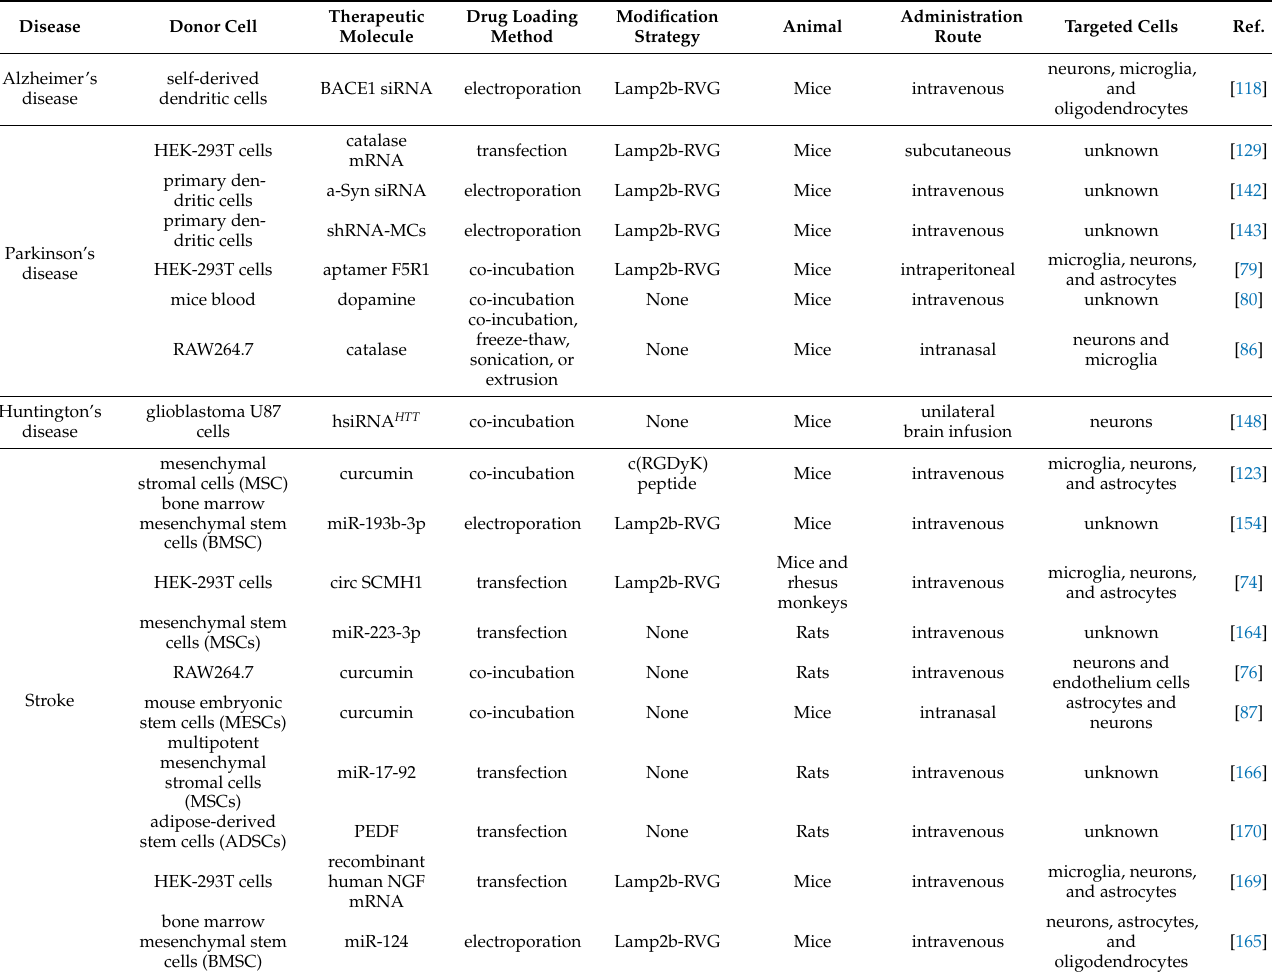
Table 1. Preclinical studies on exosomes as DDS for CNS diseases